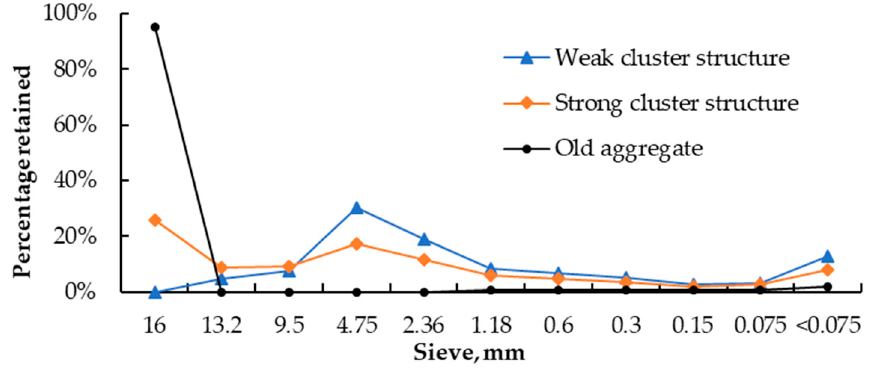
Figure 10. The Percentage Retained of Three Kinds of Structures after the Extraction Test.